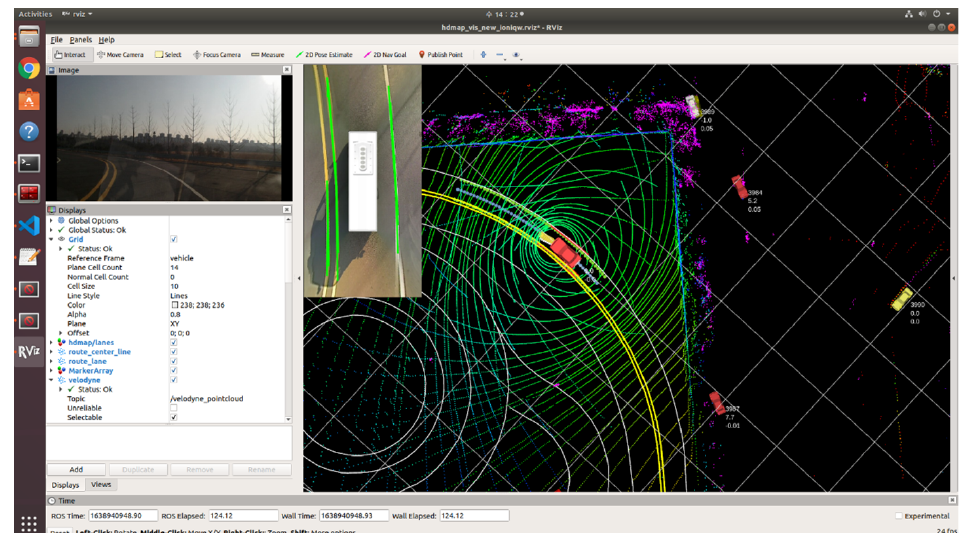
Figure 16. Application of a Proposed Precision Geospatial Mapping System for Autonomous Driving: A Case Study.